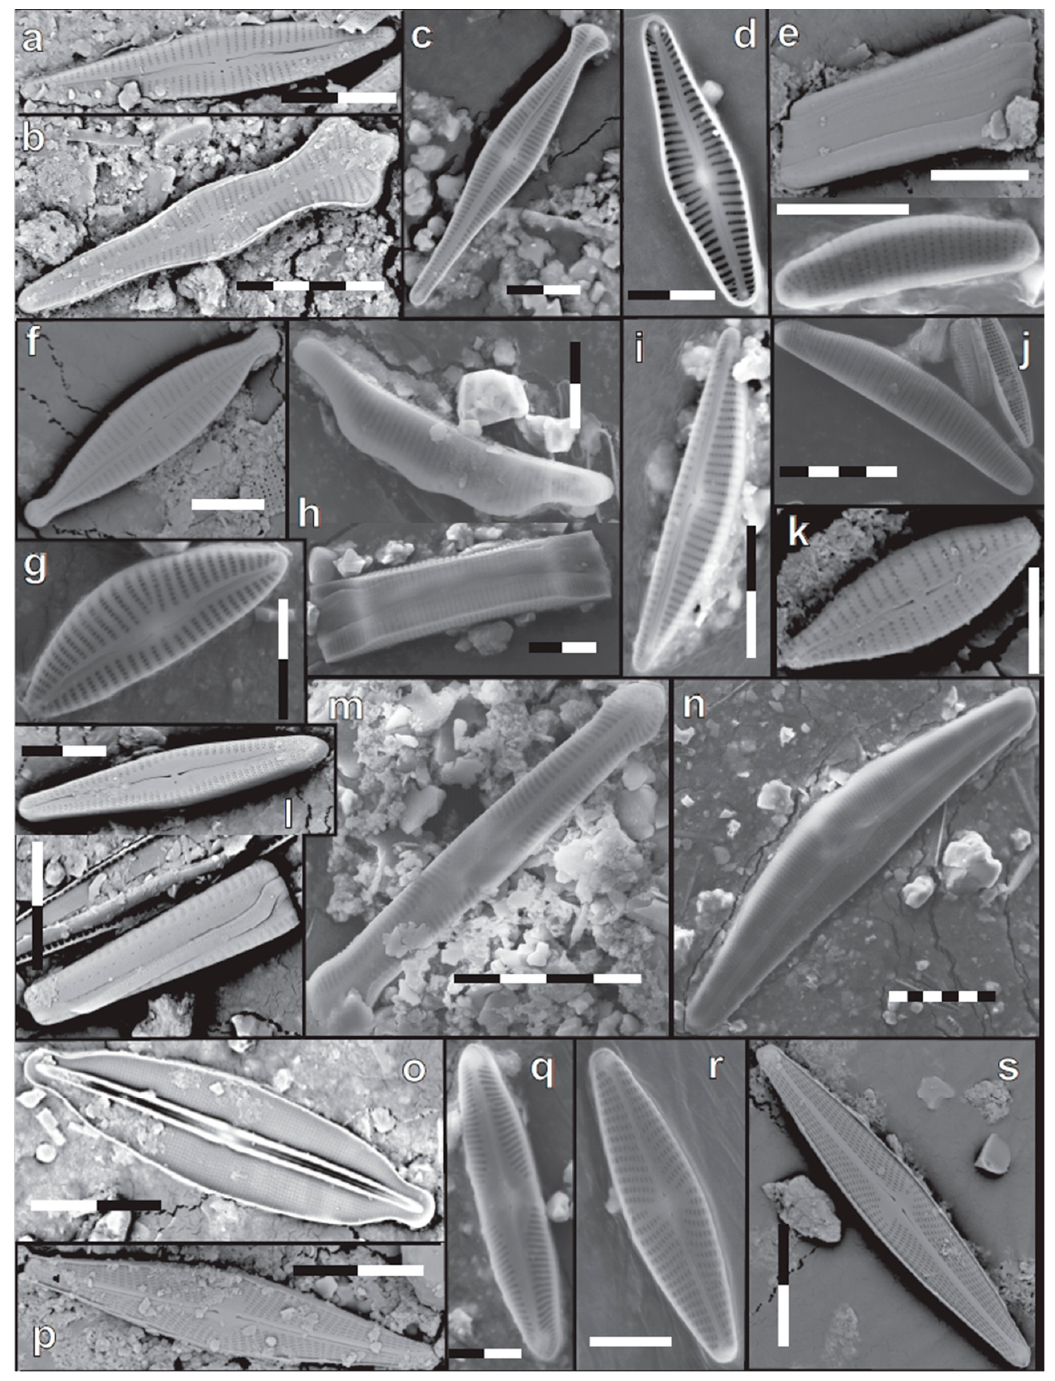
Figure 4. SEM photographs of some of the most common diatoms found in the water bodies. Each black or white part of the scale bar is 5 µm. Identifications: ( a ) Gomphonema gracile sl Ehrenberg; ( b ) Gomphonema acuminatum Ehrenberg; ( c ) Gomphonema pseudosphaerophorum H.Kobayasi; ( d ) Gomphonema cf. affine Kützing; ( e ) Eunotia rhomboidea Hustedt (girdle and valve view); ( f ) Gomphonema lagenula Kützing; ( g ) Cymbella affinis Kützing; ( h ) Eunotia pectinalis var. undulata (Ralfs) Rabenhorst (valve and girdle view); ( i ) Encyonema neogracile Krammer; ( j ) Eunotia cf. minor (Kützing) Grunow; ( k ) Gomphonema parvulum (Kützing) Kützing; ( l ) Gomphonema venusta Passy, Kociolek & Lowe (valve and girdle view); ( m ) Pinnularia gibba (Ehrenberg) Ehrenberg; ( n ) Cymbella aspera (Ehrenberg) Cleve; ( o ) Frustulia crassinervia (Brébisson ex W.Smith) Lange-Bertalot & Krammer; ( p ) Navicula cf. zanonii Hustedt; ( q ) Pinnularia divergens W.Smith; ( r ) Navicula cryptotenella Lange-Bertalot; ( s ) Navicula radiosa Kützing.